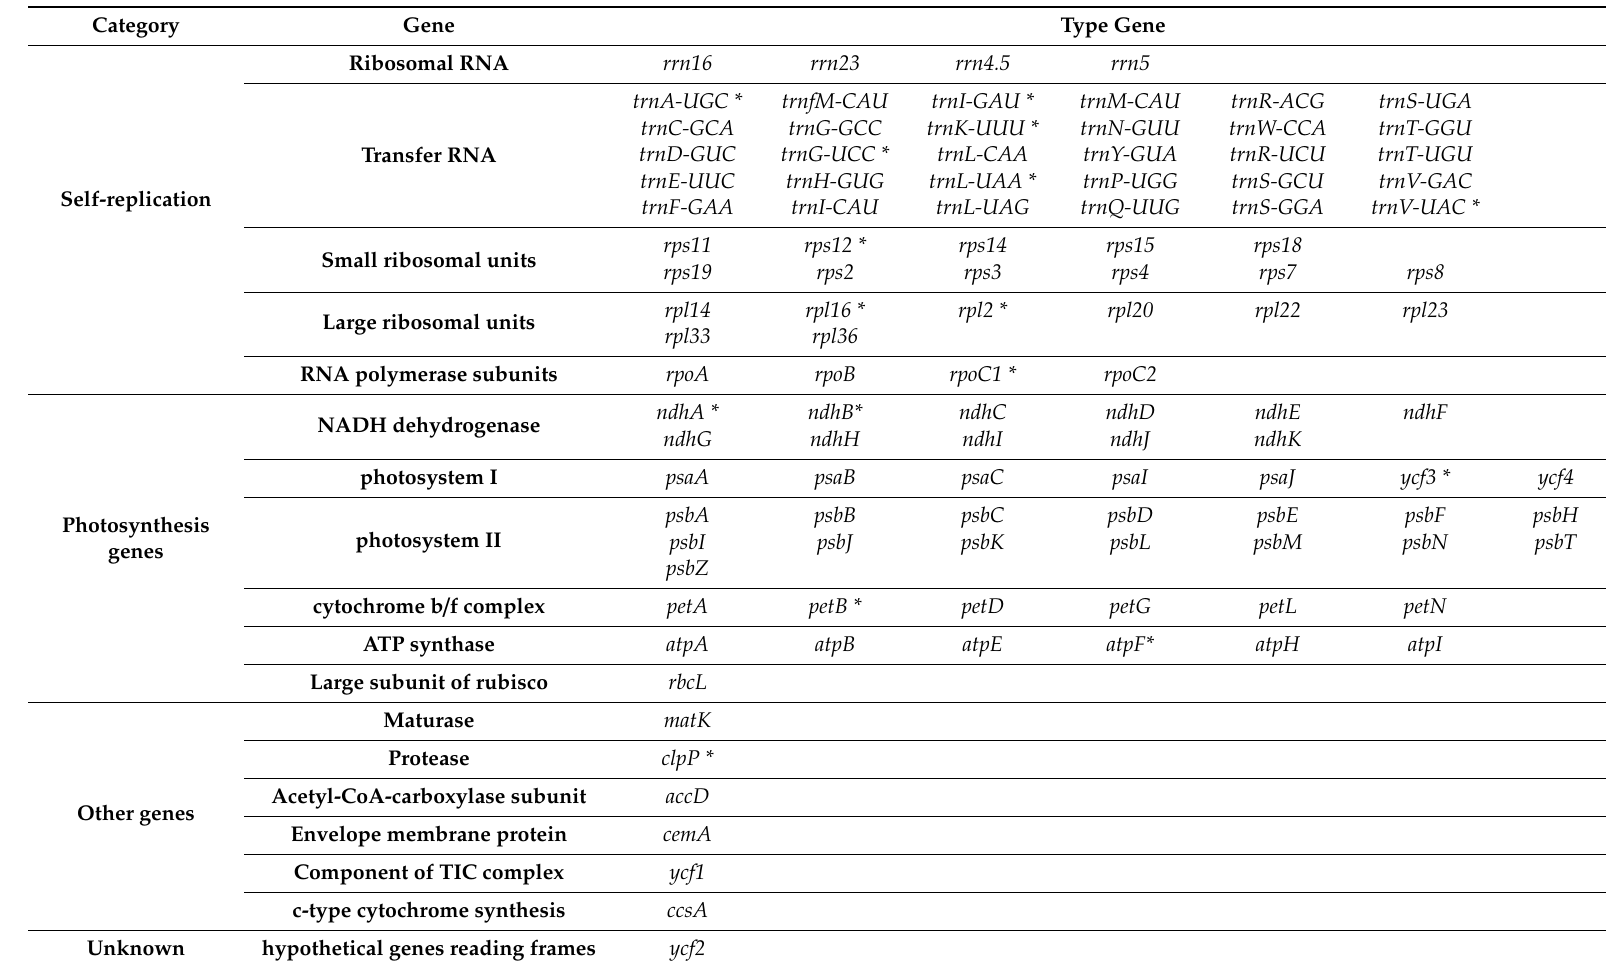
Table 2. List of genes present in the plastid genomes of twenty newly sequenced Salicaceae s.l.